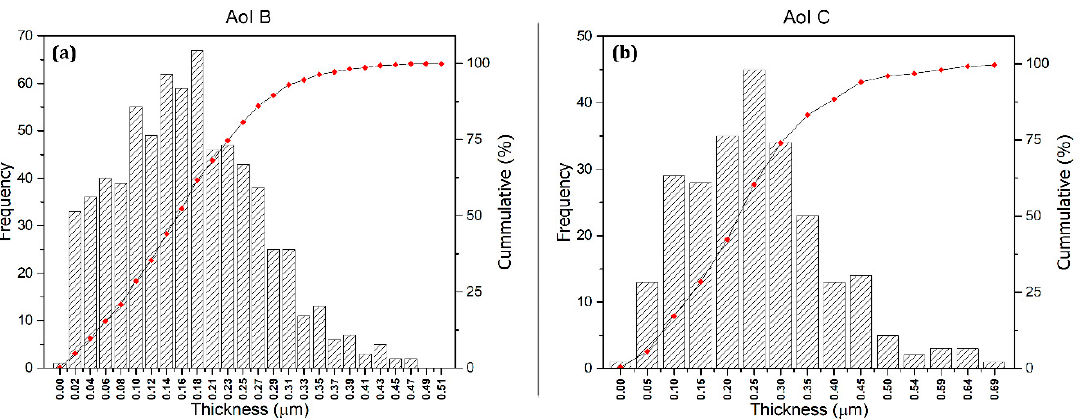
Figure 7. Histograms of measured thicknesses in AoI B ( A ) and C ( B ) corresponding to the regions with and without resin, respectively.